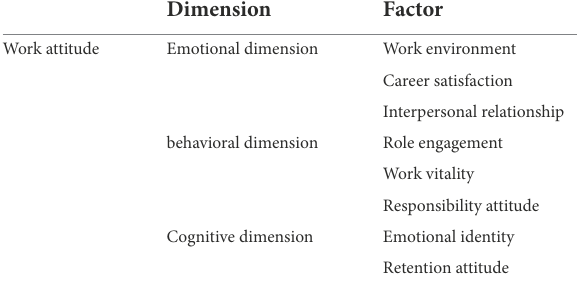
TABLE 1 Dimension and factor division of work